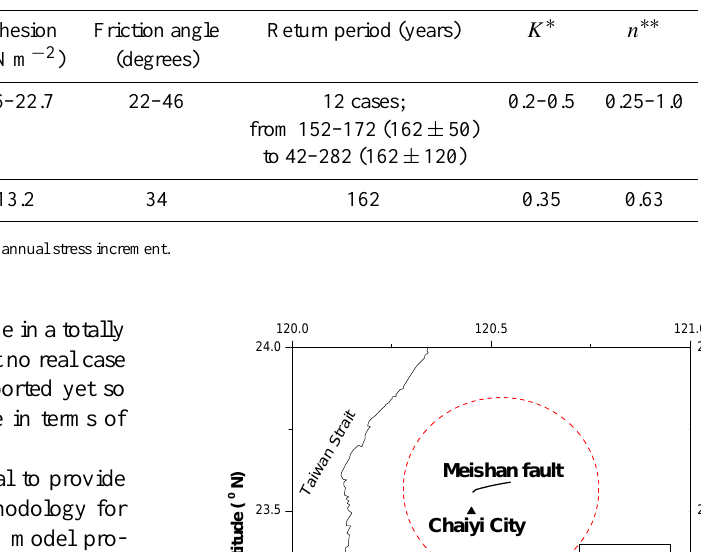
Table 1. Summary of the model parameters used in the analyses. Parameters Depth Unit weight Cohesion Friction angle Return period (years) K ∗ n ∗∗ (km) (kNm − 3 ) (MNm − 2 ) (degrees) Range 4–8 25–30